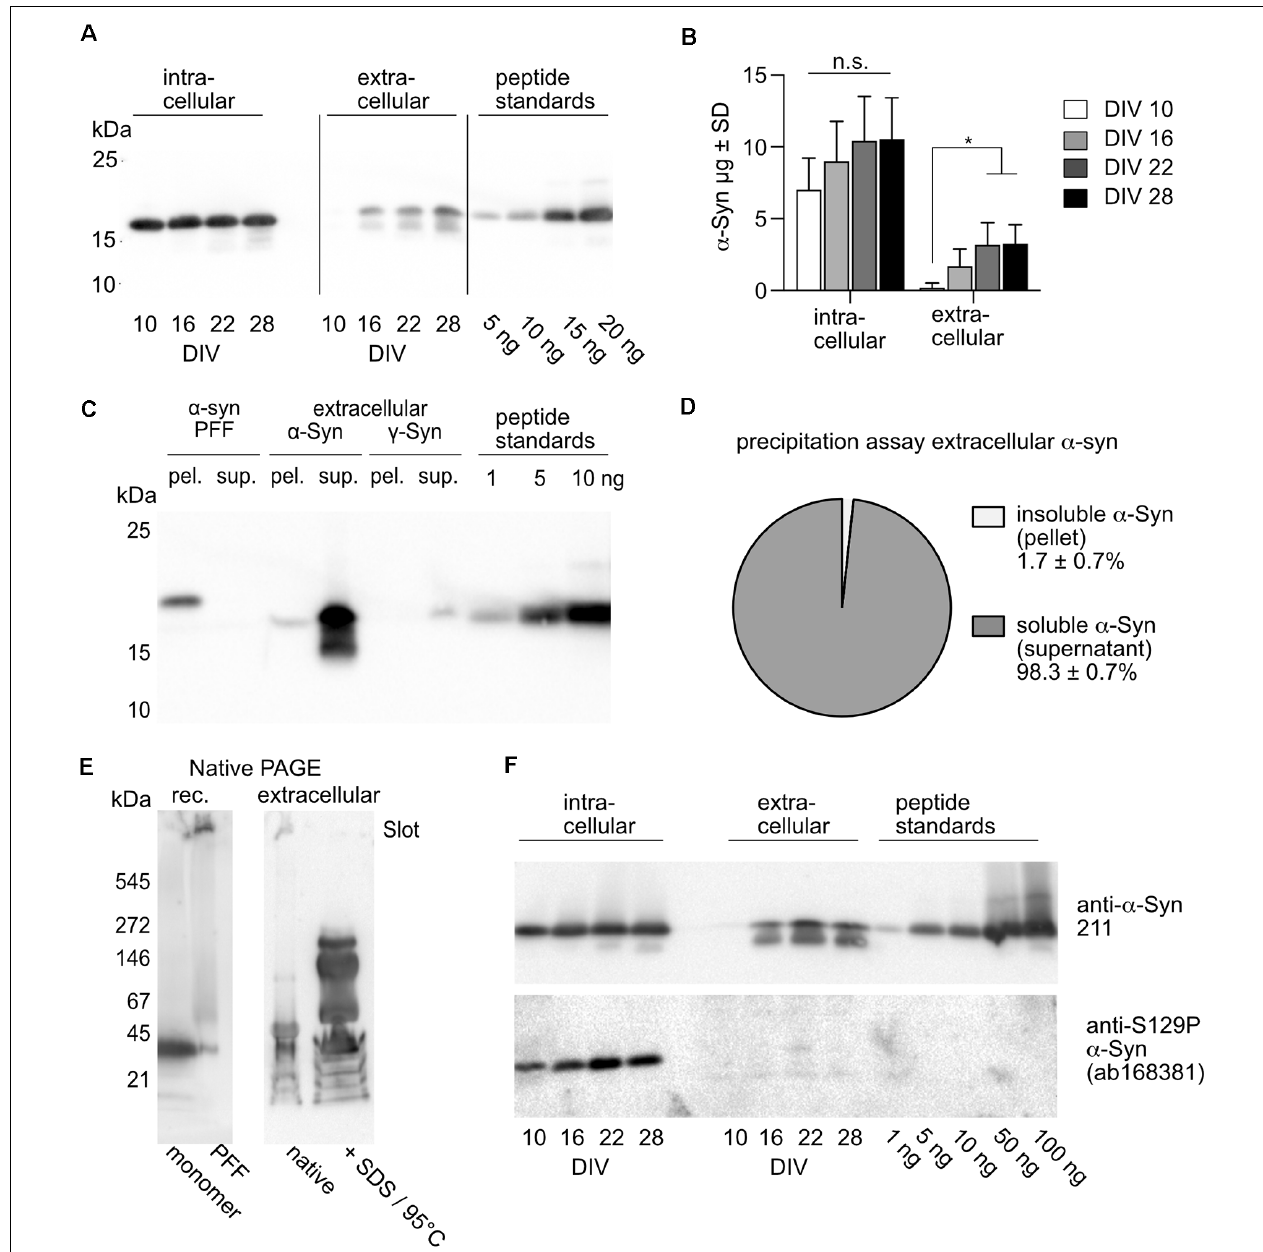
FIGURE 3 | Quantification and characterization of natively released extracellular α -Syn. (A) Western blot after SDS-PAGE showing α -Syn from cell lysate (intracellular) and from cell culture supernatant (extracellular) of neurons overexpressing human α -Syn. Recombinantly produced peptide standards were used for quantification. Detection was performed with human-specific anti- α -Syn Ab, Syn211. (B) Quantitative analysis of intra- and extracellular amounts of α -Syn at different time points. Statistics by 1-way ANOVA with Tukey’s test for multiple comparisons. Notably, the 1-way ANOVA was done separately for the four values from cell lysates and the four values from culture mediums. N = 4 independent neuronal cultures transduced with 2 × 10 8 tu of AAV- α -Syn -NmC. n.s = not significant; * p < 0.05. (C) Western blot after SDS-PAGE showing separation of soluble and insoluble α -Syn by ultracentrifugation. PFFs generated from recombinant α -Syn (6 × His tagged, resulting in higher molecular weight as compared to cell expressed α -Syn and the α -Syn used as peptide standards) were found only in the pellet (pel.) but not in the supernatant (sup.), while extracellular, natively released α -Syn was found almost exclusively in the supernatant (sup.). (D) Quantification of insoluble (pellet) and soluble (supernatant) natively released α -Syn after ultracentrifugation. N = 3 independently obtained cell culture supernatants. (E) Western blot after native PAGE of recombinant (rec.) α -Syn monomers and PFFs (left panel) and α -Syn obtained from cell culture supernatant. Cell culture supernatant was either loaded “as it is” (native) or after treatment with SDS and heating to 95 ◦ C. Detection was performed with human-specific anti- α -Syn Ab, Syn211. (F) Intracellular, but not natively secreted α -Syn is phosphorylated at S129. Western blot after SDS-PAGE showing α -Syn from cell lysate (intracellular) and from cell culture supernatant (extracellular) of neurons overexpressing human α -Syn. Recombinantly produced non-phosphorylated peptide standards served as controls for phospho-specific detection. Detection of total α -Syn was performed with human-specific anti-and α -Syn Ab, Syn211, detection of S129P α -Syn was performed with ab168381.